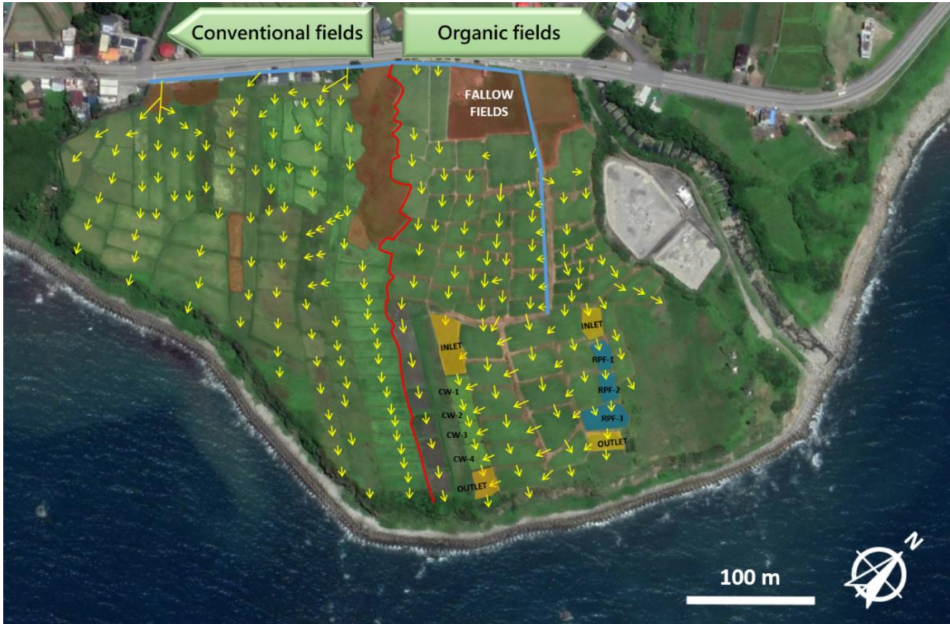
Figure 1. Fields situation of the study site in Xinshe village, Fengbin Township, Hualien County, Taiwan. The yellow arrows show the runoff direction, the blue line shows an irrigation pipe, and the red line shows the boundary of organic fields and conventional fields. Treatments applied are also shown in the figure.